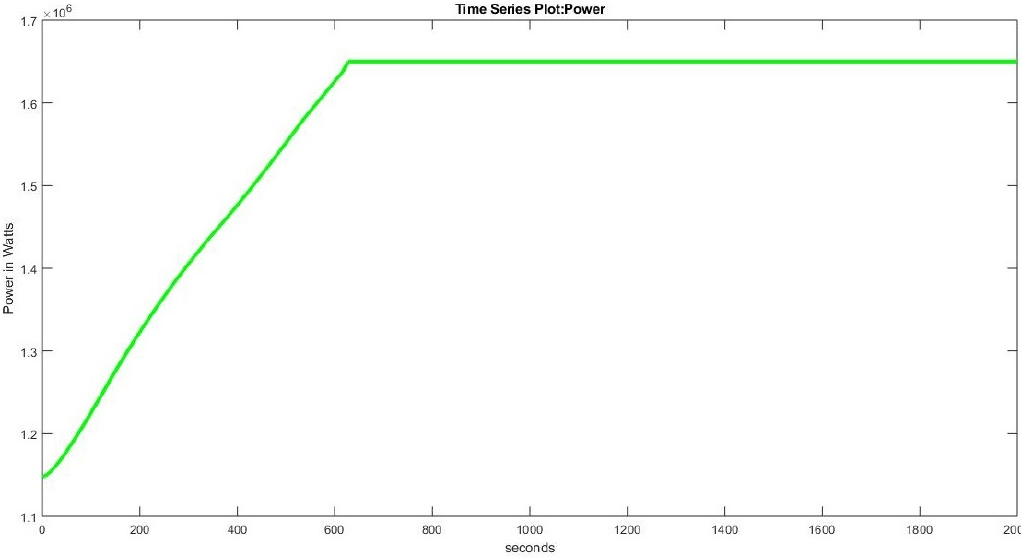
Figure 8. Power level in normal operation and desired power of 1.65 MW.